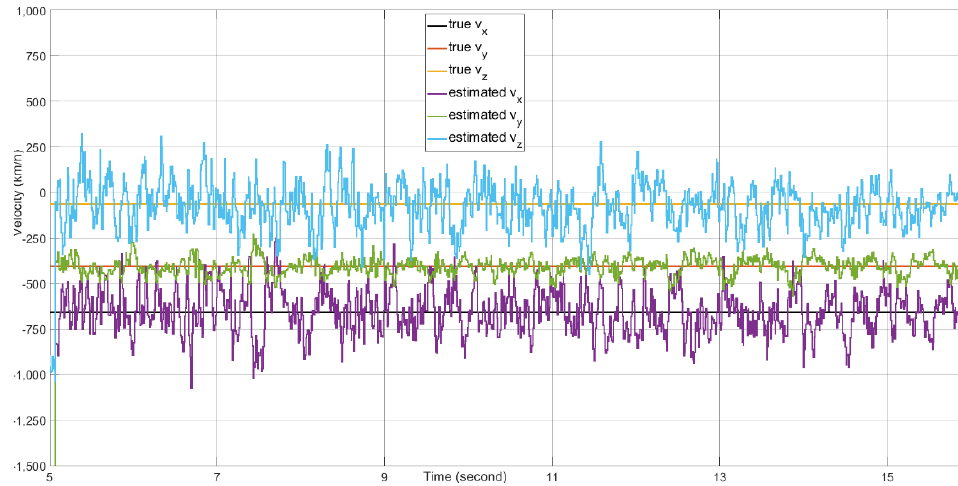
Figure 19. The velocity tracking performance over time. The velocity estimation formula follows Equation (37) in [27]. The estimation interval is 5 s. Therefore, this plot starts from 5 s. The measured root mean square tracking errors are shown in Table 3. The angle tracking errors are less than 0.004 radians, corresponding to about 0.2 degrees. The range tracing error is about 28 m. The closed loop Doppler tracking gives a small residual RMS error of 6.6 Hz. The tracking errors are mainly caused by the AWGN noise. For the angle and Doppler tracking, the residual tracking errors caused by the non-ideal responses of the tracking filters or PI controllers are negligible compared to the errors caused by the AWGN noise in this parameter setup. For the range tracking, we observe that the maximal range tracking error is about half of the actual range resolution. The range tracking error is mainly caused by the actual range resolution. The velocity errors are derived from both the angle tracking errors and the range tracking